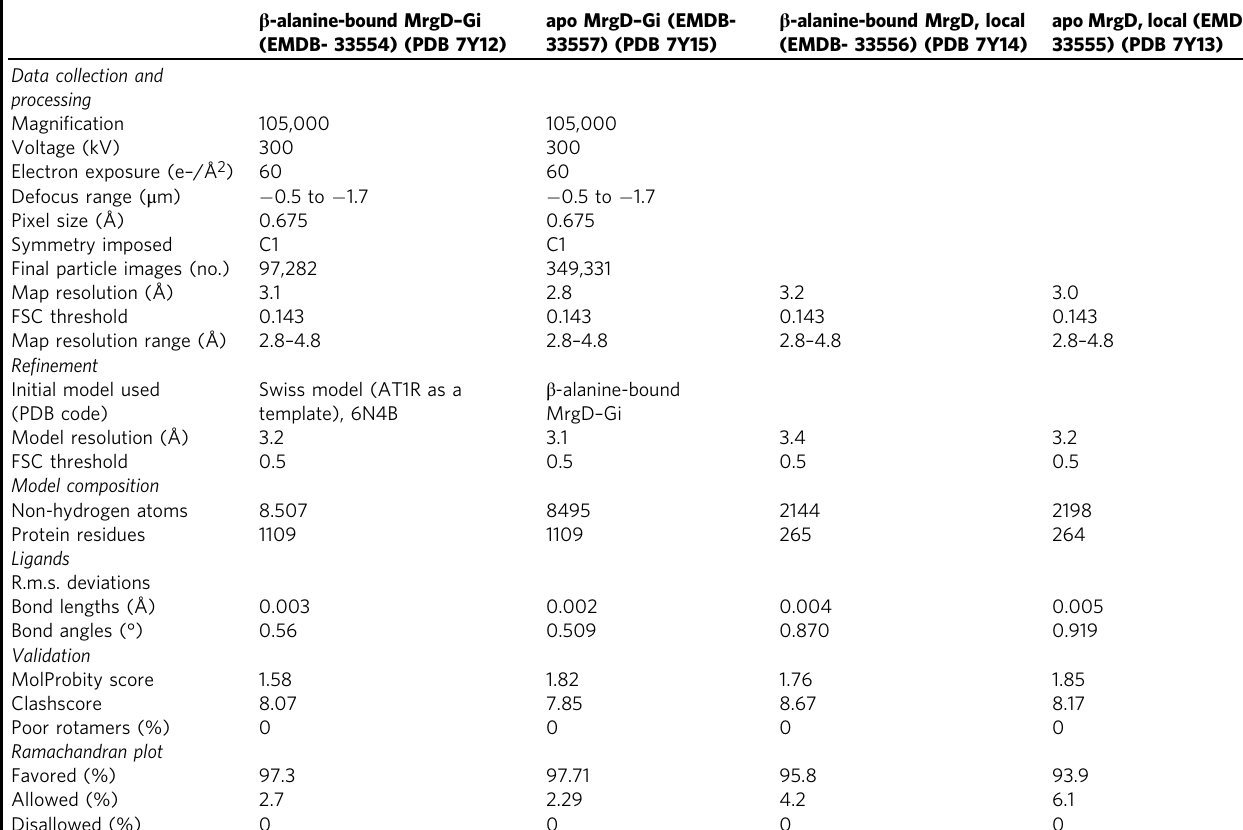
Table 1 Cryo-EM data collection, re fi nement, and validation